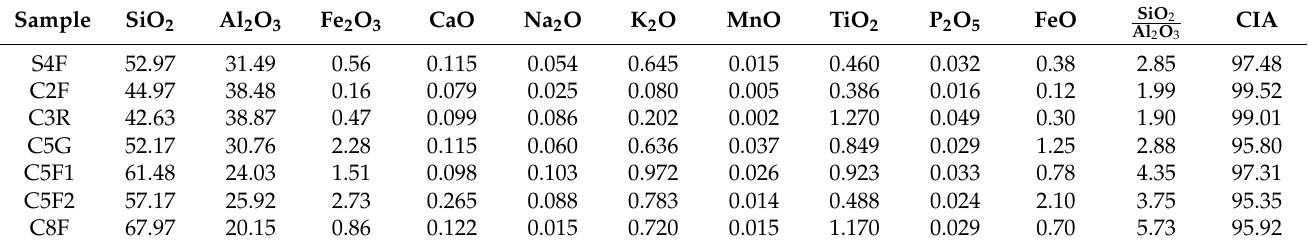
Table 4. The element oxides (%), SiO 2 /Al 2 O 3 molar ratio and CIA (%) in kaolinite